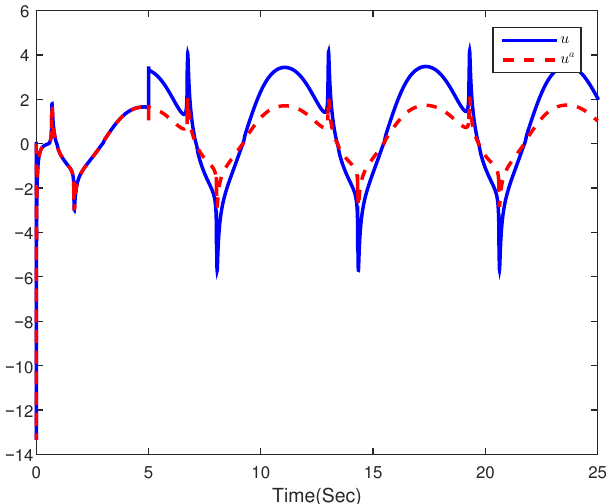
Figure 8. The curve of ˆ v (Case 2).